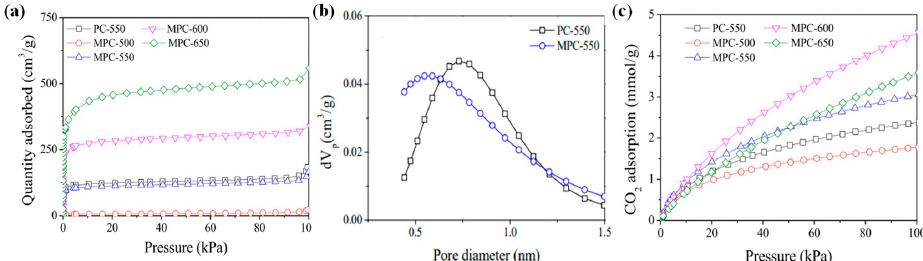
Figure 13. ( a ) N 2 adsorption/desorption isotherms of MPCs and PC-550; ( b ) pore distribution of PC-550 and MPC-550; ( c ) CO 2 adsorption isotherms of MPCs and PC-550 [116]. Reprinted with permission from Ref. [116]. Copyright 2022 Copyright Elsevier (Amsterdam, The Netherlands).